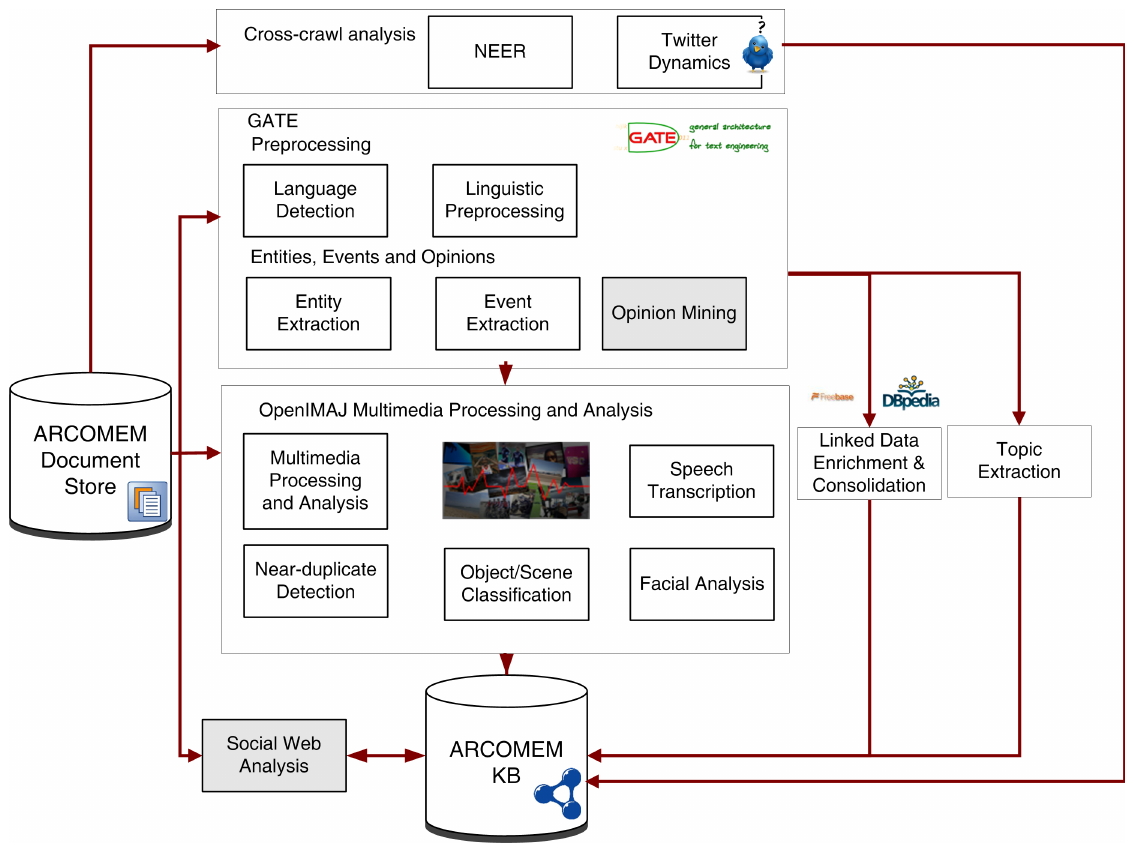
Figure 1. Processing chain for entities, topics, opinions and events (ETOEs) extraction, analysis and